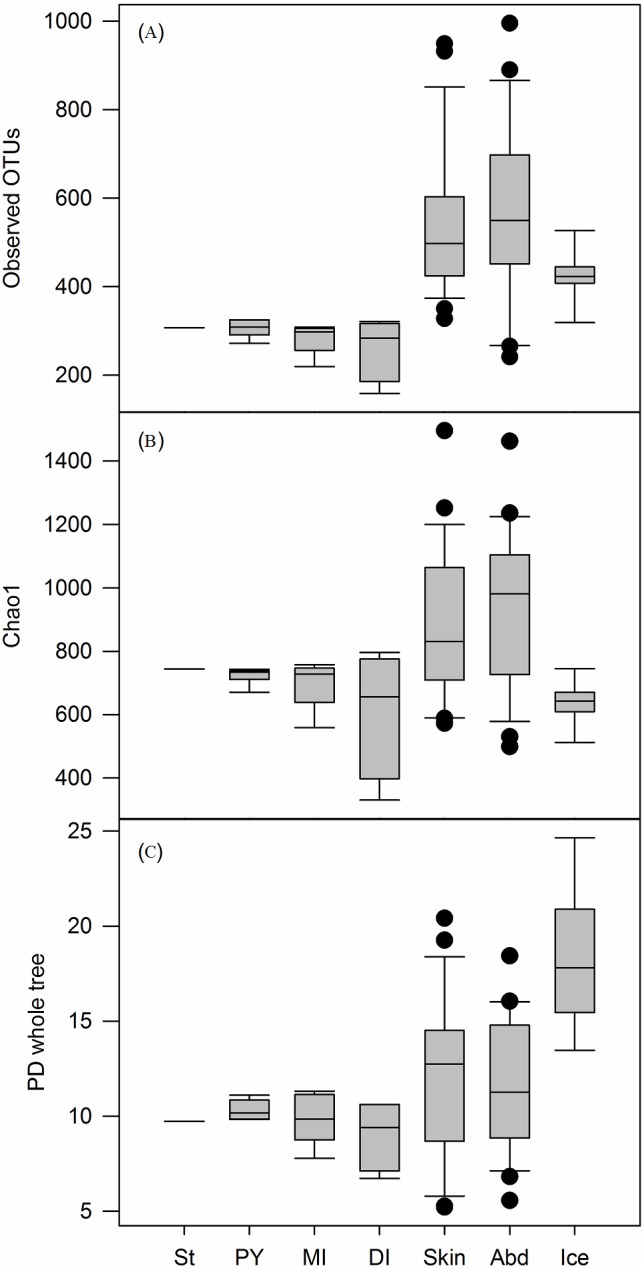
Alpha diversity estimates for all samples types.(A) Observed OTUs, (B) Chao1, and (C) PD whole tree estimates for stomach (St, n = 1), pyloric caeca (PY, n = 6), mid intestine (MI, n = 5), distal intestine (DI, n = 4), skin mucus (S, n = 25), abdominal fluids (B, n = 24) and storage ice (K, n = 8). Boxes indicate median and 1st and 3rd quartile. Whiskers indicate standard deviations and dots represent outliers. Samples and iterations for alpha diversity estimates are described in Table 1.